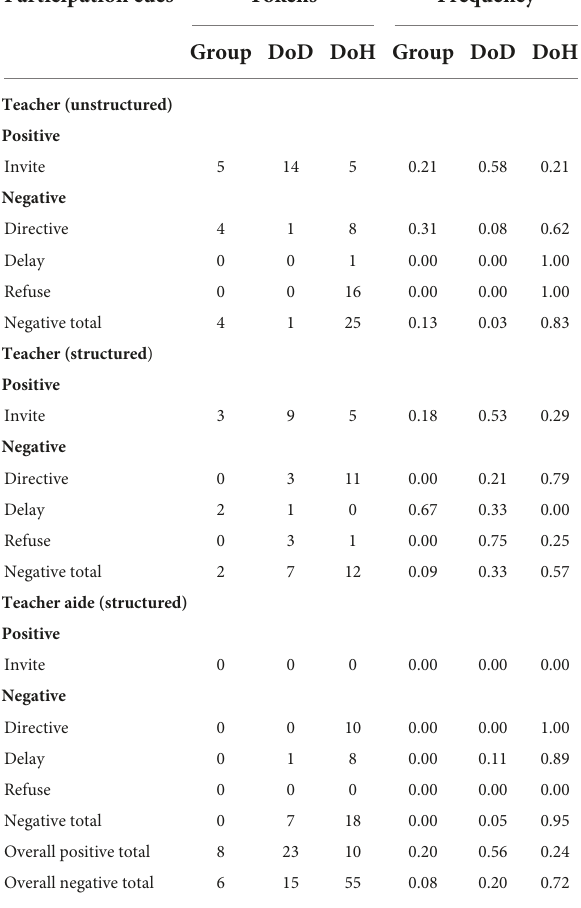
TABLE 7 Teacher and teacher’s aide participation cues in the unstructured picture walk (21:33) and structured role play (15:40)